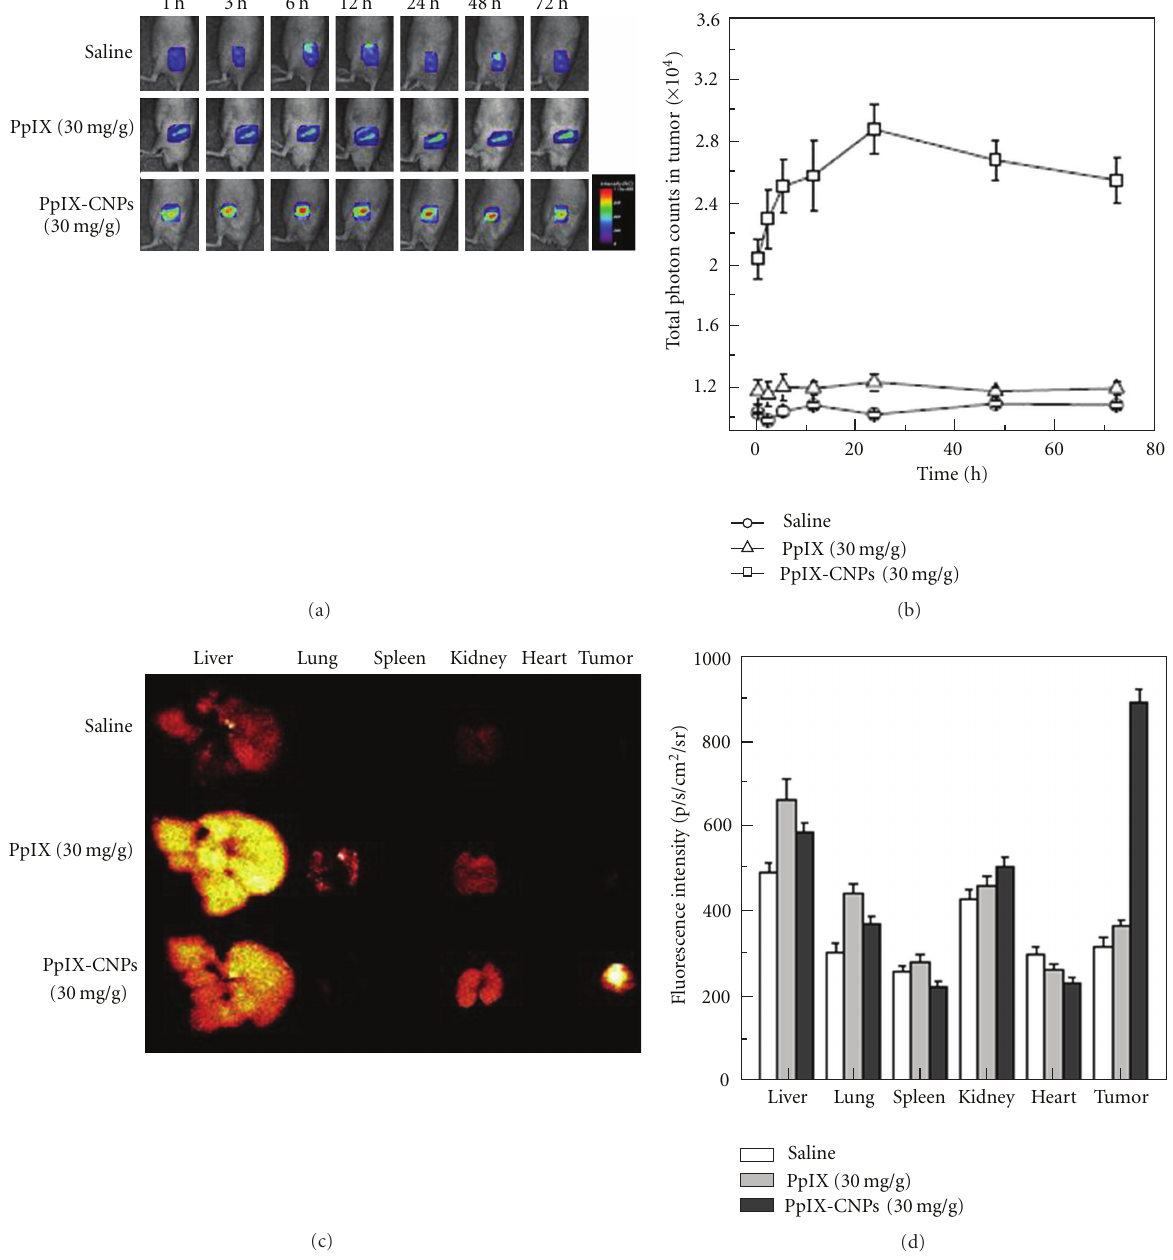
Figure 10: In vivo advantage of noninvasive fluorescence imaging tumor specificity compared to free PpIX and PpIX-polymeric nanocarriers